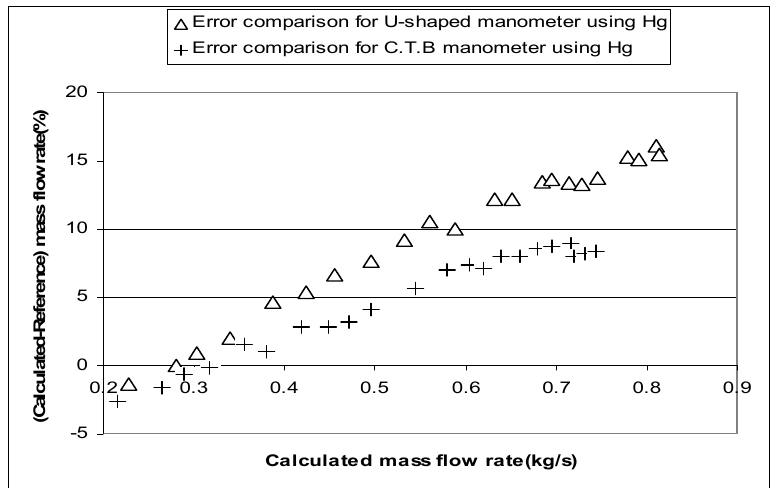
Figure 11 . Error analysis comparison between mass flow rates in case of venturimeter while using Hg as sensing